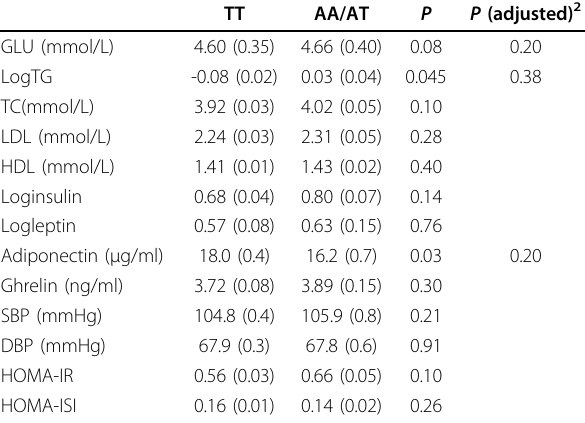
Table 4 Association of rs9939609 with obesity-related metabolic traits